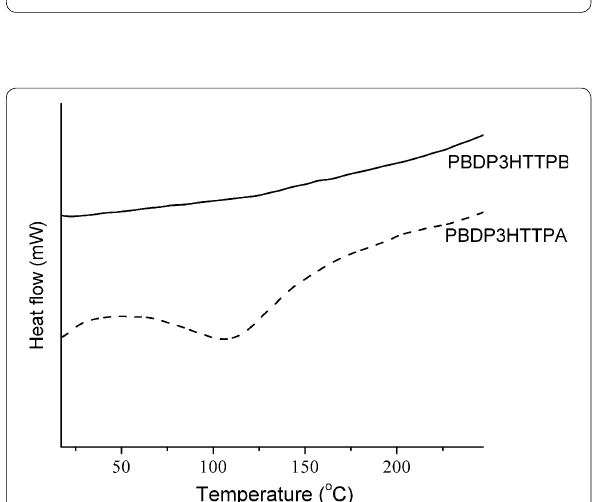
Fig. 4 TGA curves of PBDP3HTTPA and PBDP3HTTPB